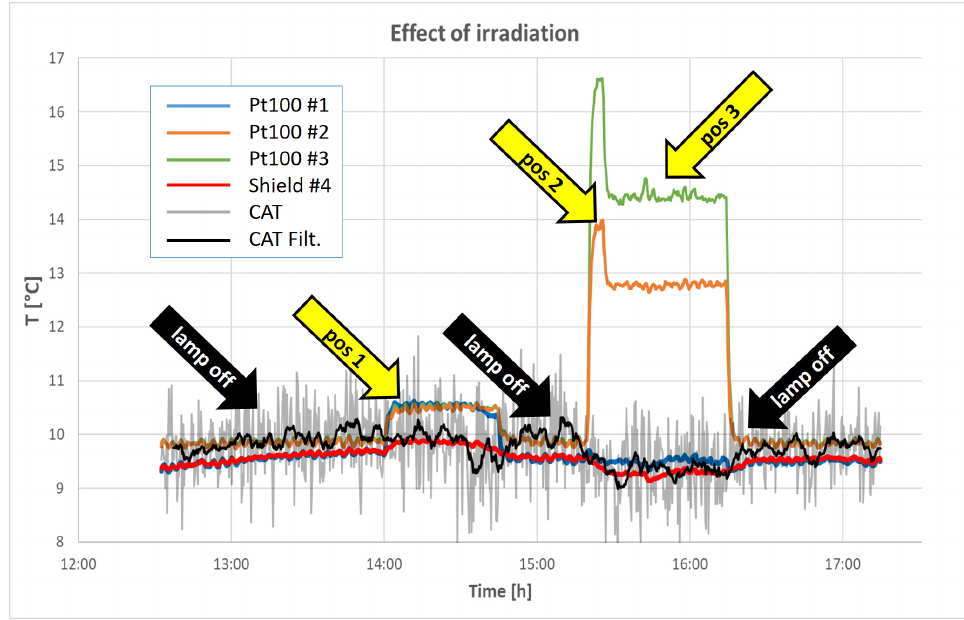
Figure 10. Typical result from the experiment to check the effect of irradiation. The set-up of the experiment is explained in the text. The blue, orange, and green lines are the temperatures recorded by three platinum thermometers used to calculate the reference temperatures for the previous measurements. The red line reports the records of a reference thermometer equipped with a solar shield screen. The labels #1 to #4 refer to the picture in Figure 5. The light grey line is the raw temperature measured with the CAT, while the black line is the moving average of the CAT readings during a period of 5 min. The yellow arrows (positions 1 to 3) indicate where the lamp is switched on and where its position is